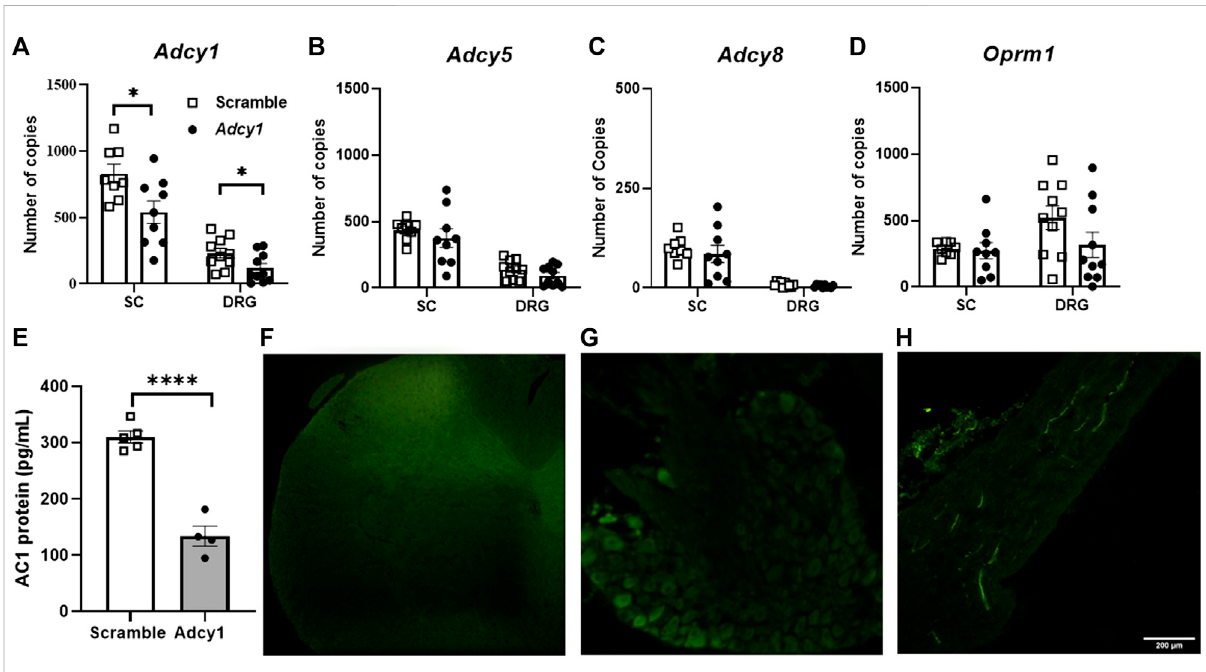
FIGURE 3 Intrathecal injection of small interfering RNA sequences targeting AC1 reduces Adcy1 mRNA in spinal cord and DRG of mice. (A) Signi fi cant reduction of Adcy1 mRNA copies present in mice injected with AAV9-ADCY1-shRNA-GFP (Adcy1) vs. AAV9-Scrambl-shRNA-GFP (Scramble; unpaired t-tests, * p < 0.05). No signi fi cant changes are seen in Adcy5 (B) , Adcy8 (C) , or Oprm1 (D) mRNA expression. n = 8 – 10/group. (E) Protein levels of AC1 collected from spinal cordare lowerin AAV9-ADCY1-shRNA-GFP (Adcy1) vs.AAV9-Scrambl-shRNA-GFP injected mice (unpaired t -test, p < 0.0001), n = 4 – 5/group. Injections were veri fi ed by Immuno fl uorescence analysis in the spinal cord (F) , DRG (G) , and sciatic nerves (H) . Scale bar = 200uM. Data presented as mean ±